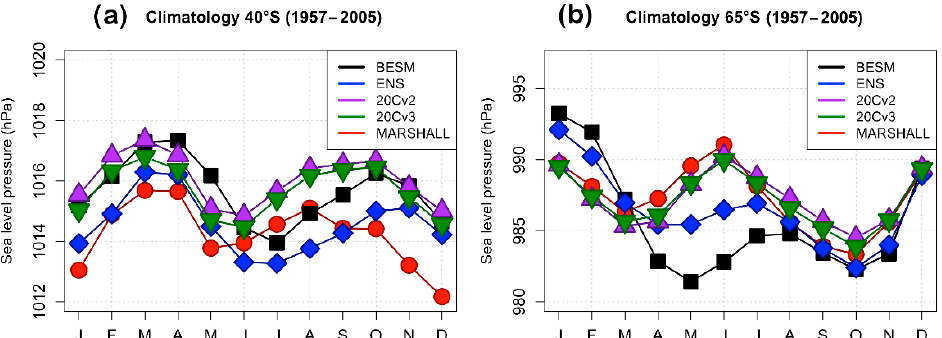
Figure 1. Monthly Mean Sea Level Pressure (MSLP, hPa) averaged over SAM GW99 index latitudes, ( a ) 40 ◦ S, and ( b ) 65 ◦ S, from January/1957 to December/2005. Black squares: BESM; blue diamonds: CMIP5 ensemble mean; purple triangles: NOAA-20Cv2 reanalysis; green upside-down triangles: NOAA-20Cv3 reanalysis; and red circles: Marshall index, surface-station derived pressure values. Seasonal reconstructions of the GW99 SAM index time series were filtered using a 10-yr moving average to examine its decadal behavior (Figure 2). We compare the indices to the CMIP5 ensemble mean spread (2 standard deviations, light blue shaded area). The two reanalysis reconstructions (purple and green lines) tend to agree in more recent times and show a difference to the Marshall index (red lines) during all seasons (Figure